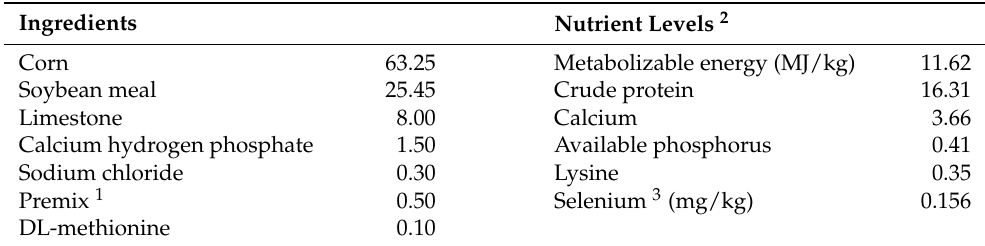
Table 1. Composition and nutrient levels of basal diet for laying hens (air dry